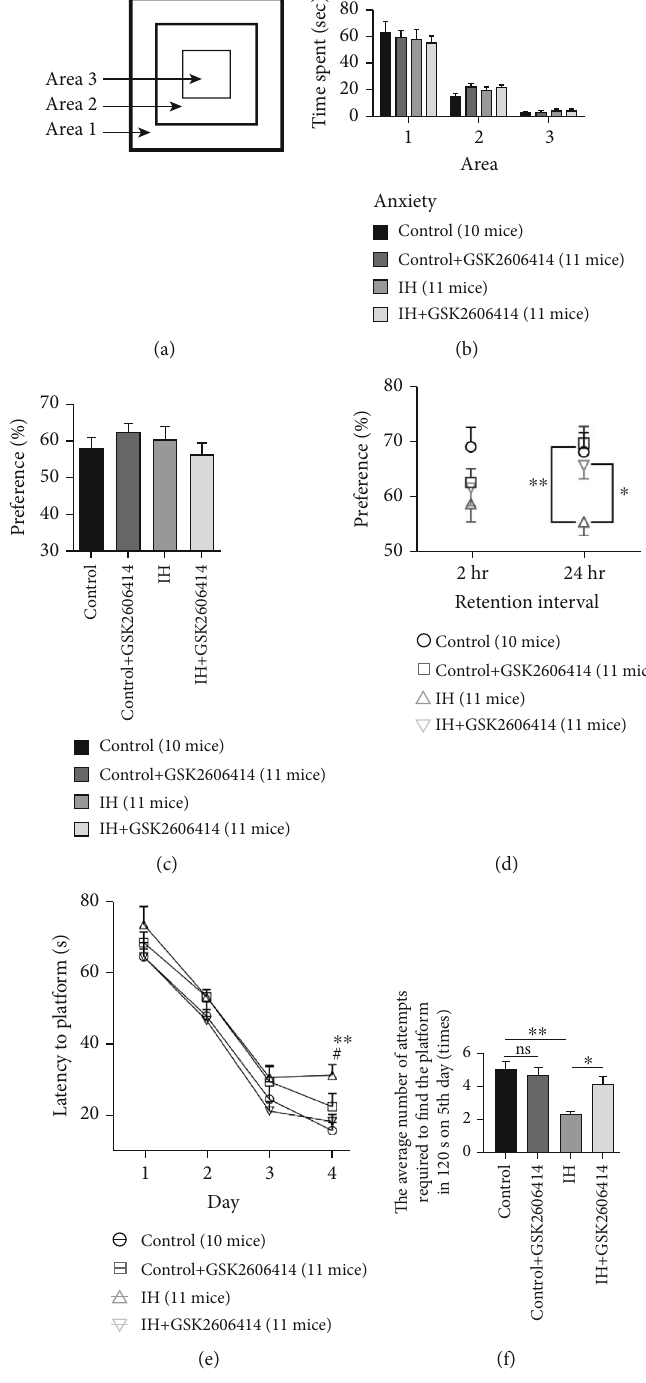
Figure 6: GSK2606414 rescued IH-induced memory impairment. (a) Anxiety levels were assessed using the open- fi eld test. Three concentric areas of the open arena were de fi ned. (b) The amounts of time animals spent in di ff erent areas did not di ff er among groups. (c) The animals in the di ff erent groups showed no preference for one object over another identical object during the training phase. (d) The percentage of time spent exploring the novel object was signi fi cantly reduced in the IH group during the trial phase 24h after training. The higher preference for the novel object was restored by GSK2606414. ∗ P < 0 : 05 ; ∗∗ P < 0 : 01 . (e) The escape latencies were increased in the IH group on the fourth day and were reduced by GSK2606414. ∗∗ P < 0 : 01 control vs. IH; # P < 0 : 05 IH vs. IH+GSK2606414. (f) IH increased the number of attempts required to fi nd the platform, and this e ff ect was reduced by GSK2606414. ∗ P < 0 : 05 ; ∗∗ P < 0 : 01 ; ns: not signi fi